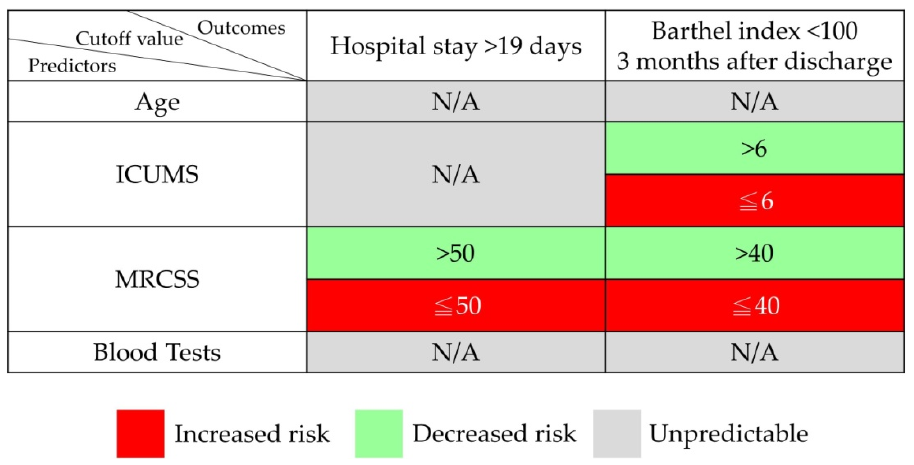
Figure 3. The ROC curve of ICUMS and MRCSS in predicting those hospitalized more than 19 days.